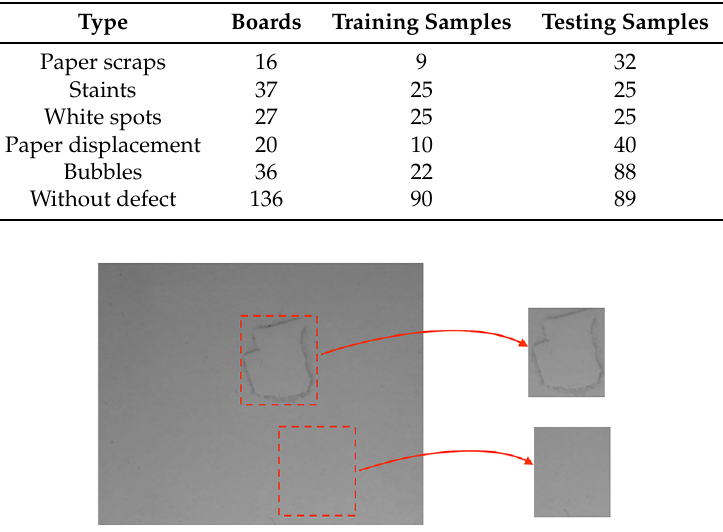
Figure 4. Regions of interest generation for a defect and a non-defect area, in a melamine faced